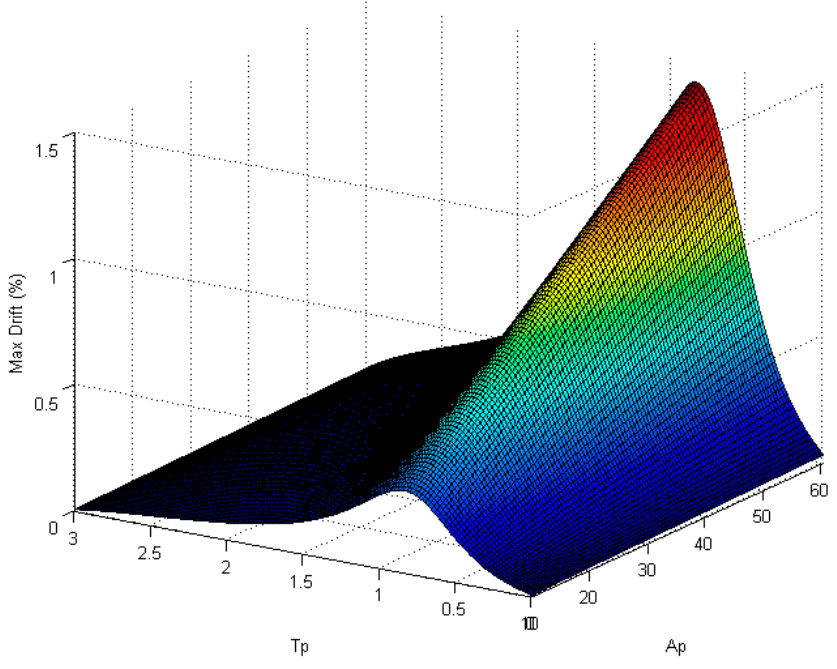
Figure 10. The EDP response surface of the bridge to simplified Gabor pulses.